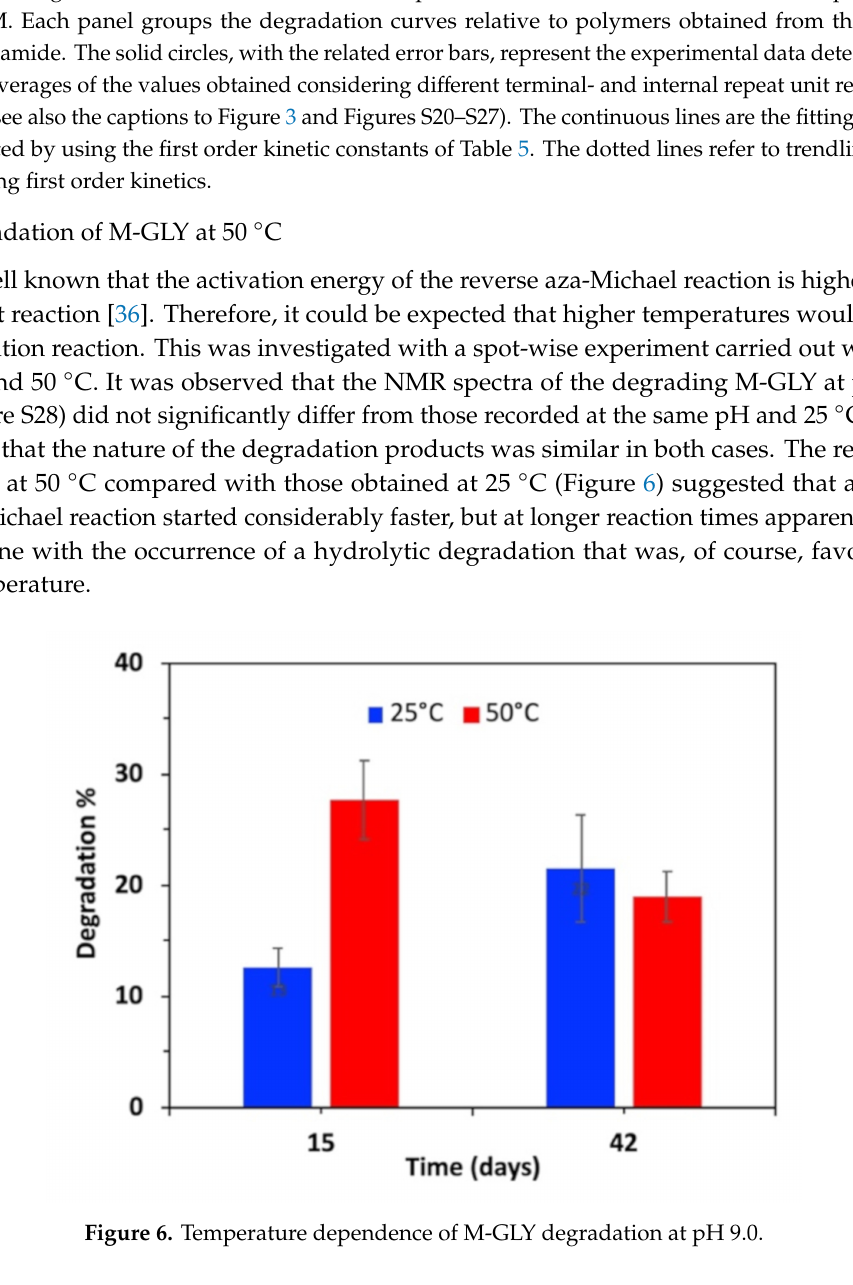
Figure 5. Degradation kinetics of linear PAAs at pH 9.0 and 25 °C. Concentration of the repeat unit 43.6 μ M. Each panel groups the degradation curves relative to polymers obtained from the same bisacrylamide. The solid circles, with the related error bars, represent the experimental data determined as the averages of the values obtained considering different terminal- and internal repeat unit reference peaks (see also the captions to Figures 3 and S20–S27). The continuous lines are the fitting curves calculated by using the first order kinetic constants of Table 5. The dotted lines refer to trendlines not following first order kinetics.